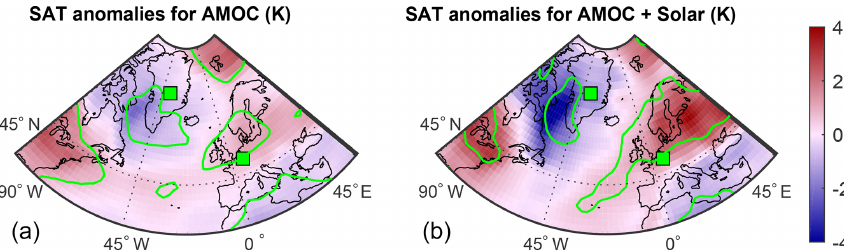
Figure 7. (a) Winter (DJF) surface air temperature anomalies for negative AMOC years compared to positive AMOC years for the period 1961–2005CE in 20th century climate reanalysis (see Fig. S4). The green markers point to the location of Summit and of MFM, while the green contour lines represent significance levels for p < 0 . 1 ( t test). (b) Same as (a) but for years of both negative AMOC and high solar